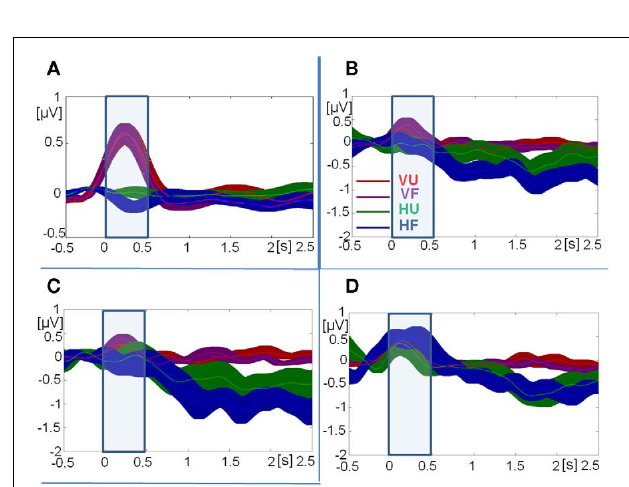
FIGURE 9 |Time courses of grand-mean evoked activity. (A) Theta-band activity at fronto-central sites. (B) Upper alpha-band activity at central occipital sites. (C) Upper alpha-band activity at left occipital sites. (D) Upper alpha-band activity at right occipital sites. Note: different scales for theta-band (A) and upper alpha-band activity (B–D) . Error bars indicate SE of the mean at every time-sample.VU, visual unfamiliar;VF, visual familiar; HU, haptic unfamiliar; HF, haptic familiar.The blue square indicates the analysis